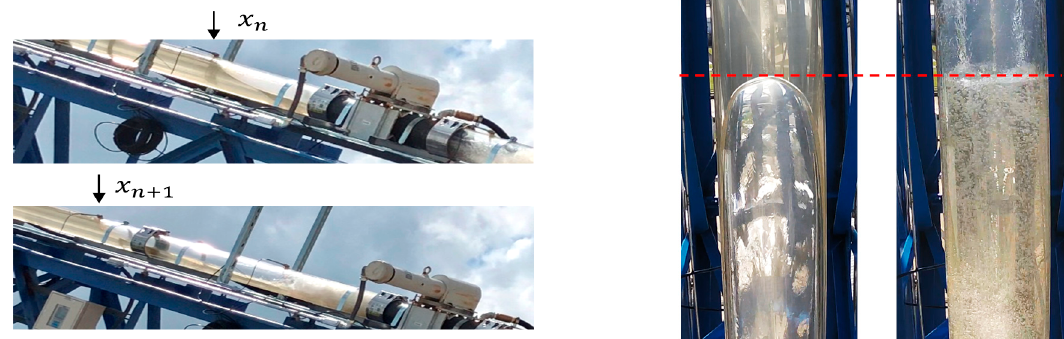
Figure 6. Determination of the velocity and length of Taylor bubble.